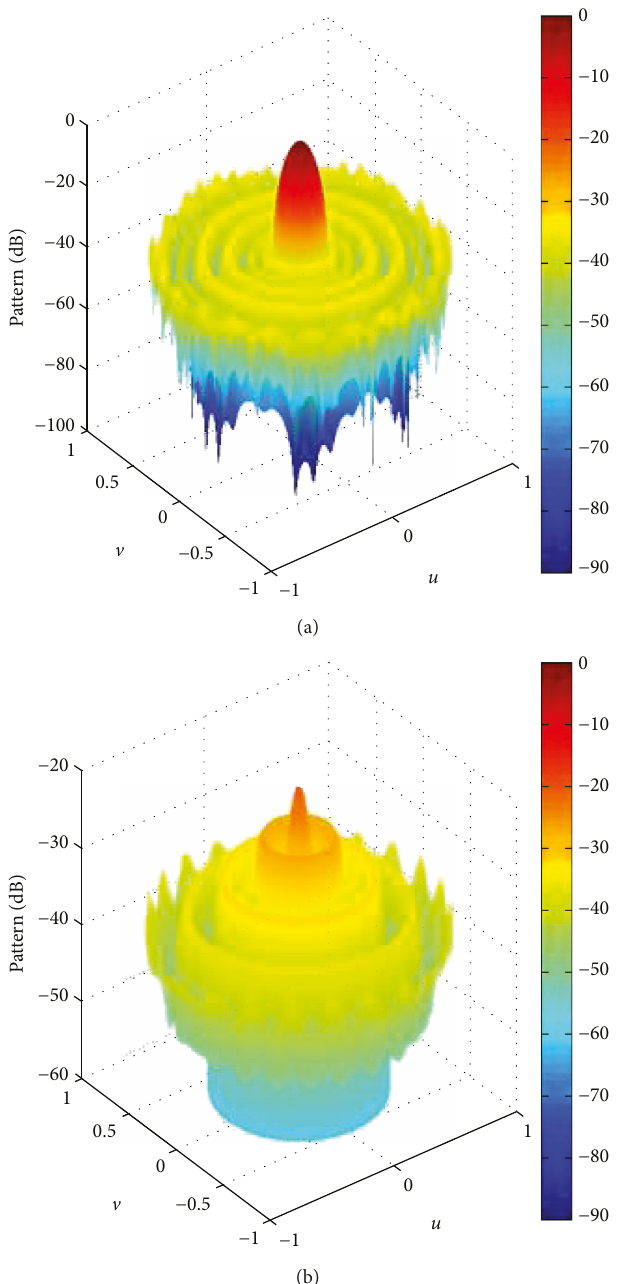
Figure 6: Radiation patterns for individual C 2 : (a) at the center frequency ( s =0) and (b) at the fi rst sideband ( s